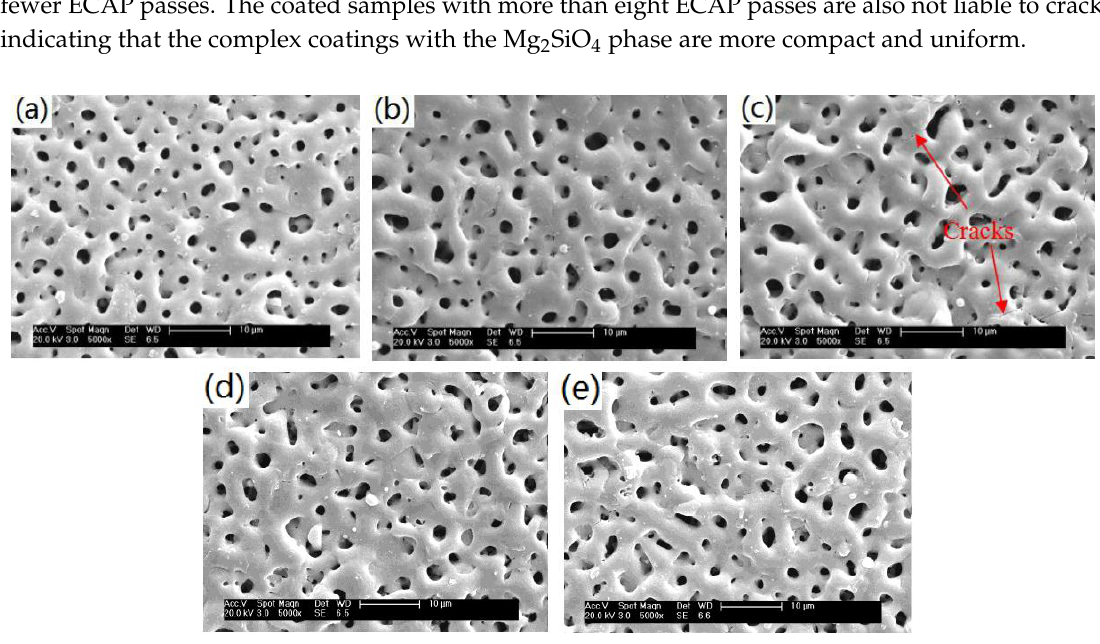
Figure 3. SEM images of the surface of the micro-arc oxidation coatings on ( a ) the cast AZ91D alloy and the ECAPed ones at 523 K for ( b ) 4 passes; ( c ) 8 passes; ( d ) 12 passes and ( e ) 16 passes.